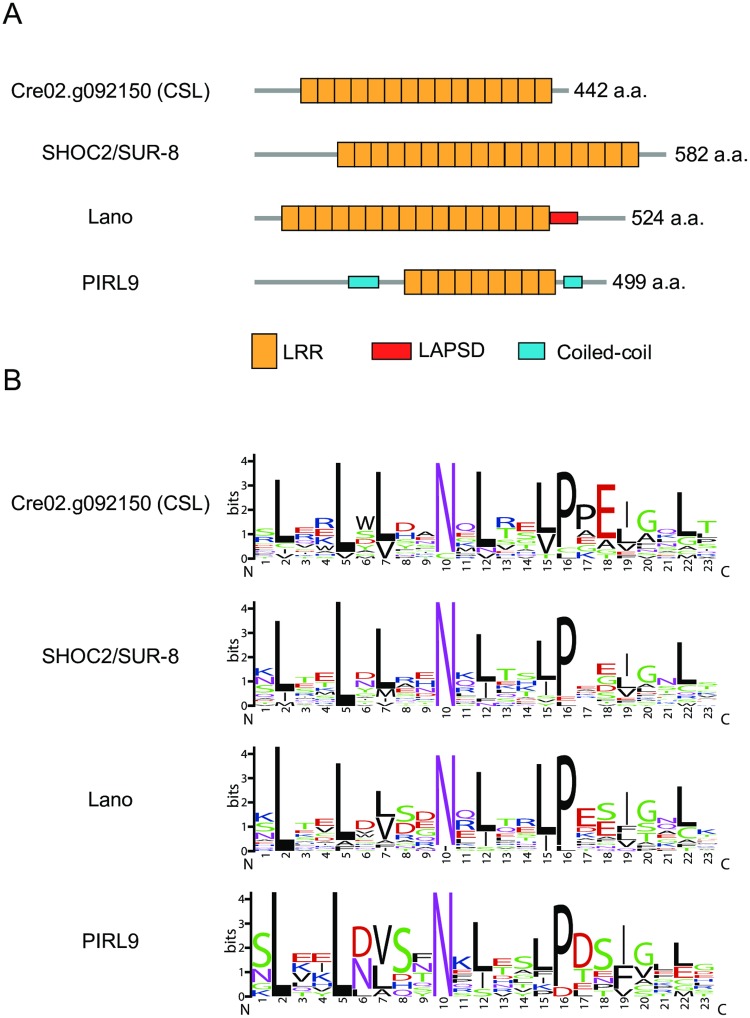
Sequence analysis of Cre02.g092150.(A) Schematic representation of domain architecture of Cre02.g092150 and other LRR proteins. PIRL9 is shown as a representative of the PIRL family. (B) Consensus LRR sequences visualized by the program WebLogo (http://weblogo.berkeley.edu/)[49].